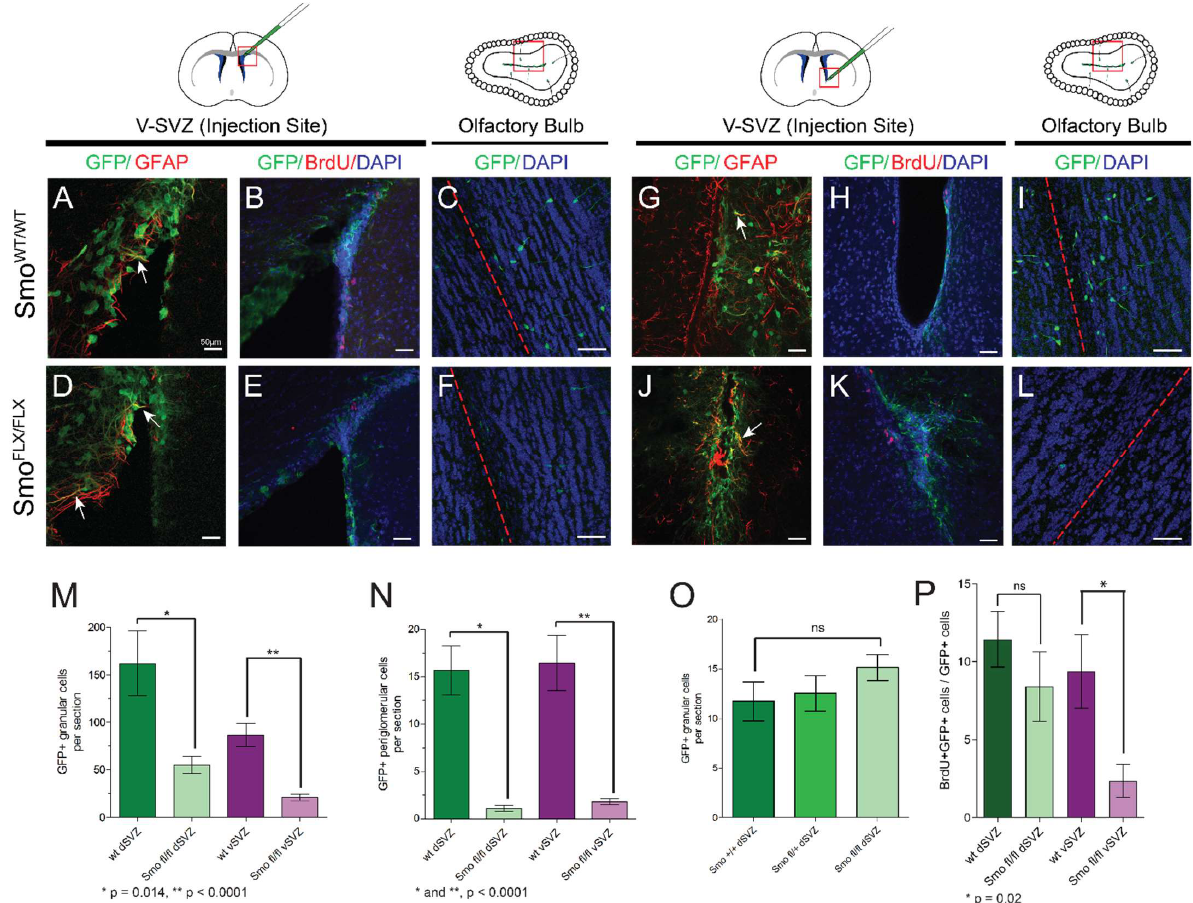
Figure 2. SMO is required for production of olfactory bulb interneurons in V-SVZ: Ad-GFAPp-Cre virus was injected in either dorsal ( A – F ) or ventral ( G – L ) V-SVZ in CAG or Smo flx/flx ; CAG animals, and brain tissue was analyzed 30 days after injection. Approximate locations of the imaged areas are indicated by red boxes. GFP/GFAP double-labeled cells were found at the injection site (arrows in A , D , G , J ), and GFP-labeled progeny were scored in the olfactory bulb for all sites and genotypes ( C , F , I , L ). Scale bars—50 microns; red dashed lines indicate the core of the olfactory bulb. Loss of Smoothened resulted in significant decreases in labeled cells in both the granule cell layer ( M ) and periglomerular cell layer ( N ) of the olfactory bulb, regardless of whether virus was injected dorsally or ventrally. Bar plots each show mean value +/− SEM ( n = 4 to 5 sections each from each of 4 or 5 animals per location and genotype; p values for unpaired t- test are shown below each plot). This difference was not seen in control dorsal injections of Ad:CMVp-GFP ( O ) ( n = 4 to 5 sections each from each of 3 or 4 animals per genotype). ( P ) Quantification of BrdU/GFP double-positive cells at ( n = 3 to 4 sections each from each of 3 or 4 animals per genotype; p value for unpaired t -test is shown beneath